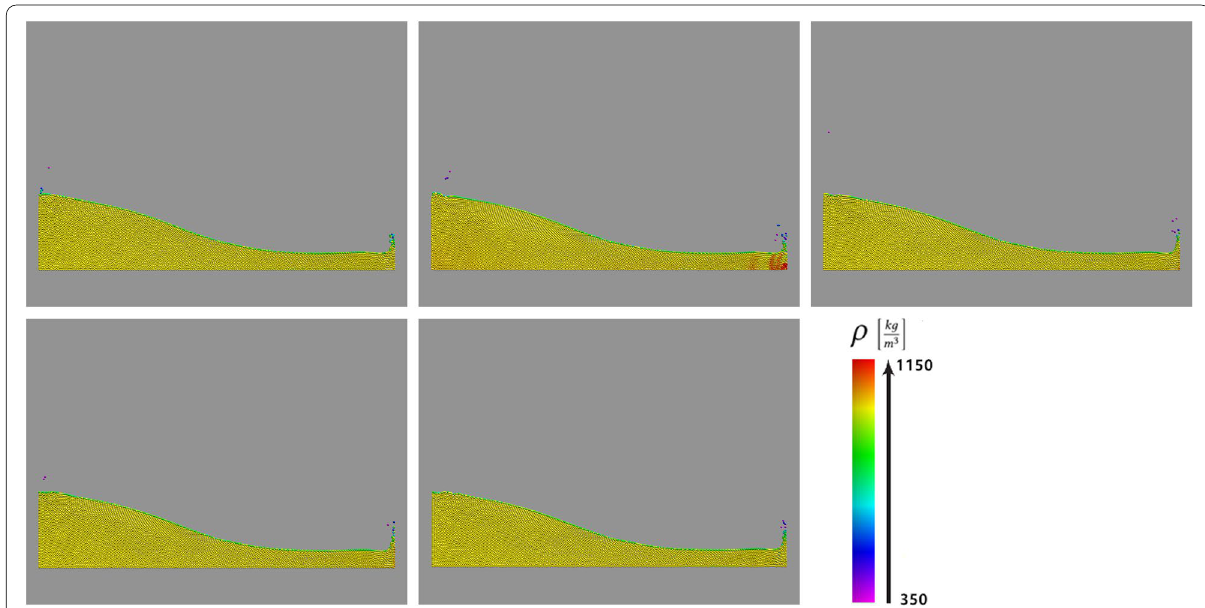
Fig. 6 Fluid density fields of a 2D dam-break scenario simulated using different SPH-based algorithms (5476 particles). Top: VSLSPH (currently proposed), WCSPH [14], and PCISPH [7] methods; Bottom: IISPH [8] and DFSPH [9, 10] methods